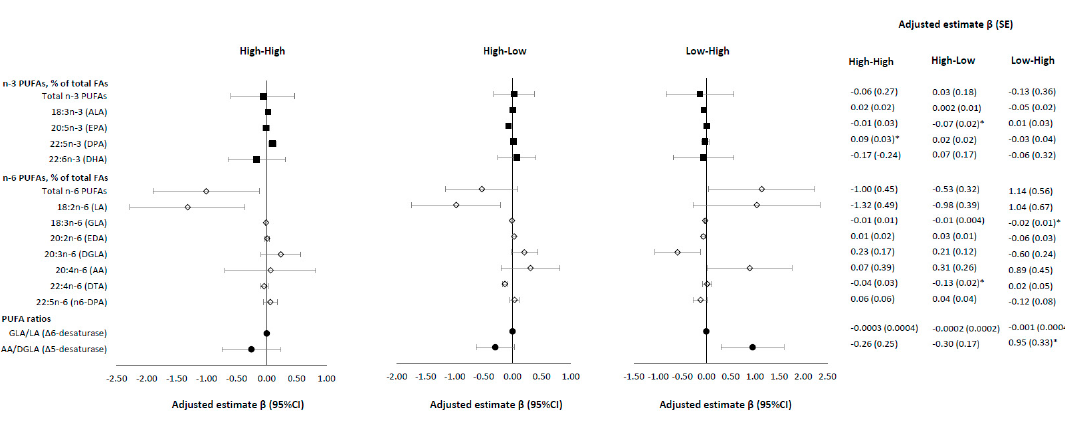
Figure 1. Changes in maternal moderate-to-vigorous physical activity (MVPA) levels between visit 0 (gestational weeks (GW): 8–13) and visit 4 (GW: 34–37) and plasma phospholipid polyunsaturated fatty acids (PUFAs) at visit 4 in the NICHD Fetal Growth Studies—Singleton Cohort. * p -value is significant after Bonferroni correction. Four groups by MVPA on the basis of their visit 0 and visit 4 data (High: MVPA ≥ 150 min / week; Low: MVPA < 150 min / week). High-High (High MVPA at visit 0 and High MVPA at visit 4, N = 40); High-Low (High MVPA at visit 0 and Low MVPA at visit 4, N = 90); Low-High (Low MVPA at visit 0 and High MVPA at visit 4; N = 15); Low-Low (Low MVPA at visit 0 and Low MVPA at visit 4, N = 136; reference group). Multivariable linear regression models adjusted for age (years), race, education, marriage status, nulliparous, and pre-pregnancy body mass index (BMI; kg / m 2 ), and Alternative Health Eating Index (AHEI) score. Sampling weights were applied to all analyses to represent the full NICHD Fetal Growth Studies—Singletons population. Abbreviations: FAs, fatty acids; PUFAs, polyunsaturated fatty acids; AA, arachidonic acid; ALA, alpha-linolenic acid; DGLA, dihomo-gamma-linolenic acid; DHA, docosahexaenoic acid; DPA, docosapentaenoic acid; DTA, docosatetraenoic acid; EDA, eicosadienoic acid; EPA, eicosapentaenoic acid; GDM, gestational diabetes mellitus; GLA, gamma-linolenic acid; LA, linoleic